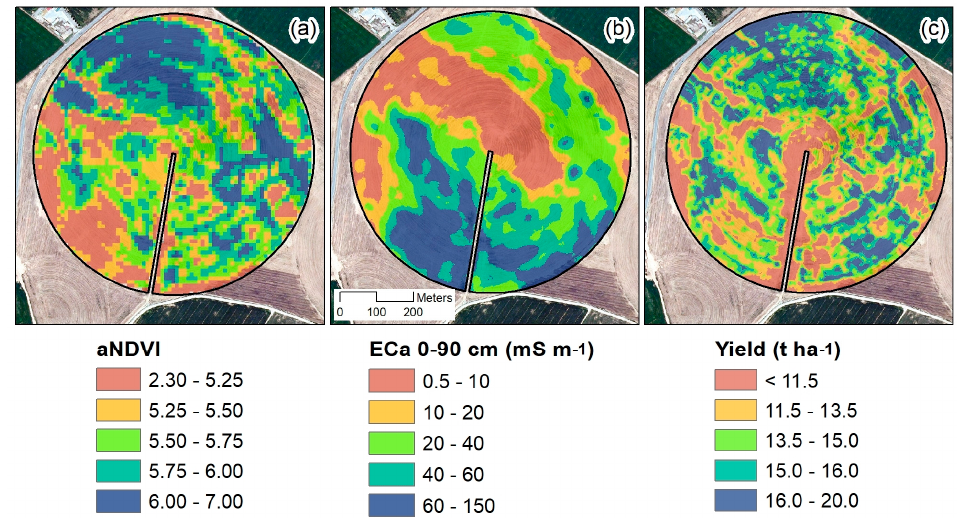
Figure 5. ( a ) Accumulated NDVI (aNDVI), ( b ) apparent soil electrical conductivity (ECa) at 0–90 cm, and ( c ) maize yield with 14% grain moisture content. The maps are displayed according to five intervals of quantile distribution. Table 3. Summary statistics of the accumulated NDVI (aNDVI), apparent soil electrical conductivity (ECa) at 0–90 cm, and maize yield with 14% grain moisture content. Variable Min Max Mean Standard Deviation CV (%) aNDVI 2.3